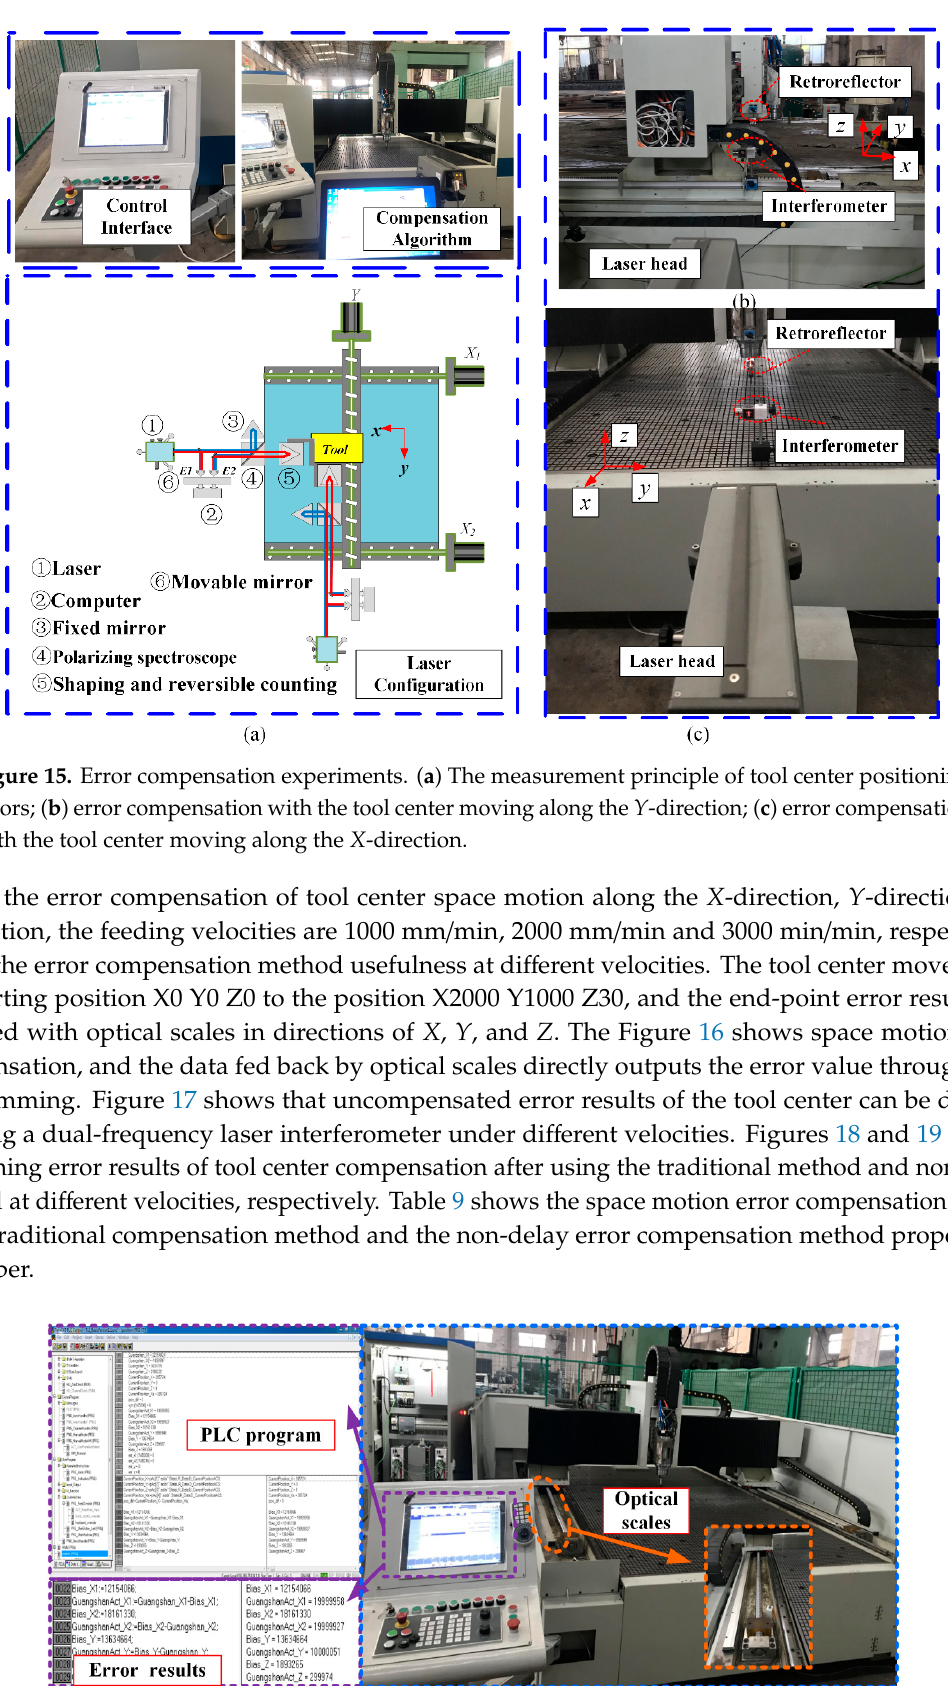
Figure 16. Space motion error compensation experiments.